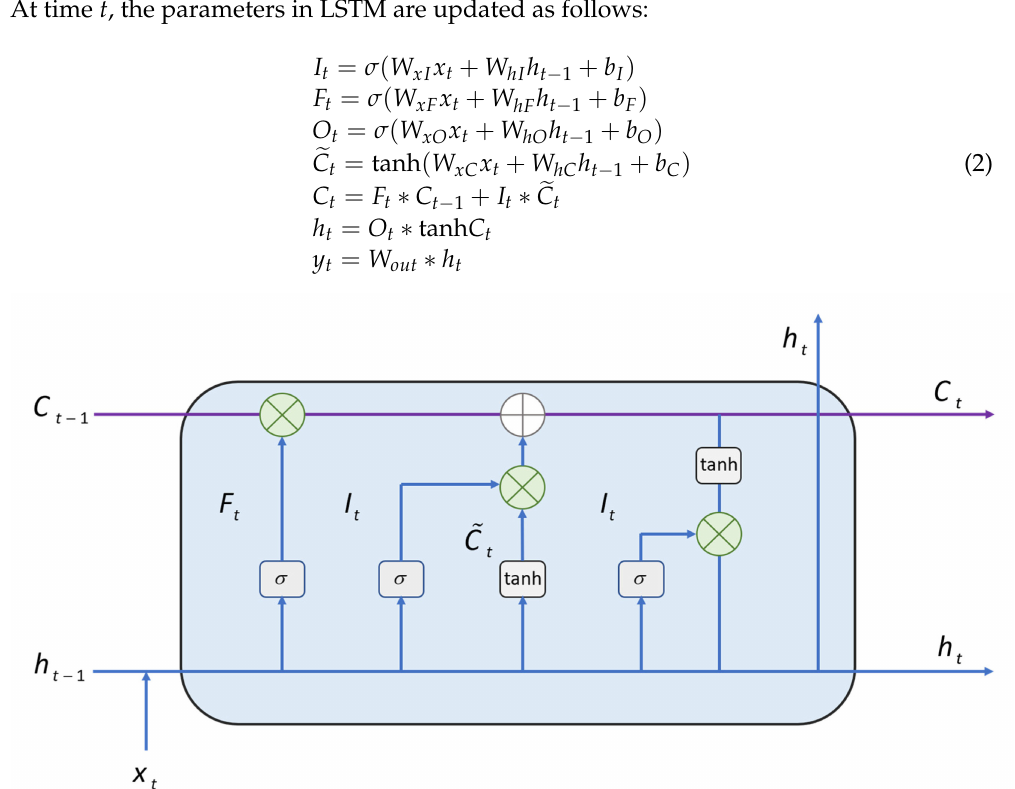
Figure 1. The operation flow of LSTM at time t . The input at time t is the output at time t − 1, while the output at time t is used as the input at time t +